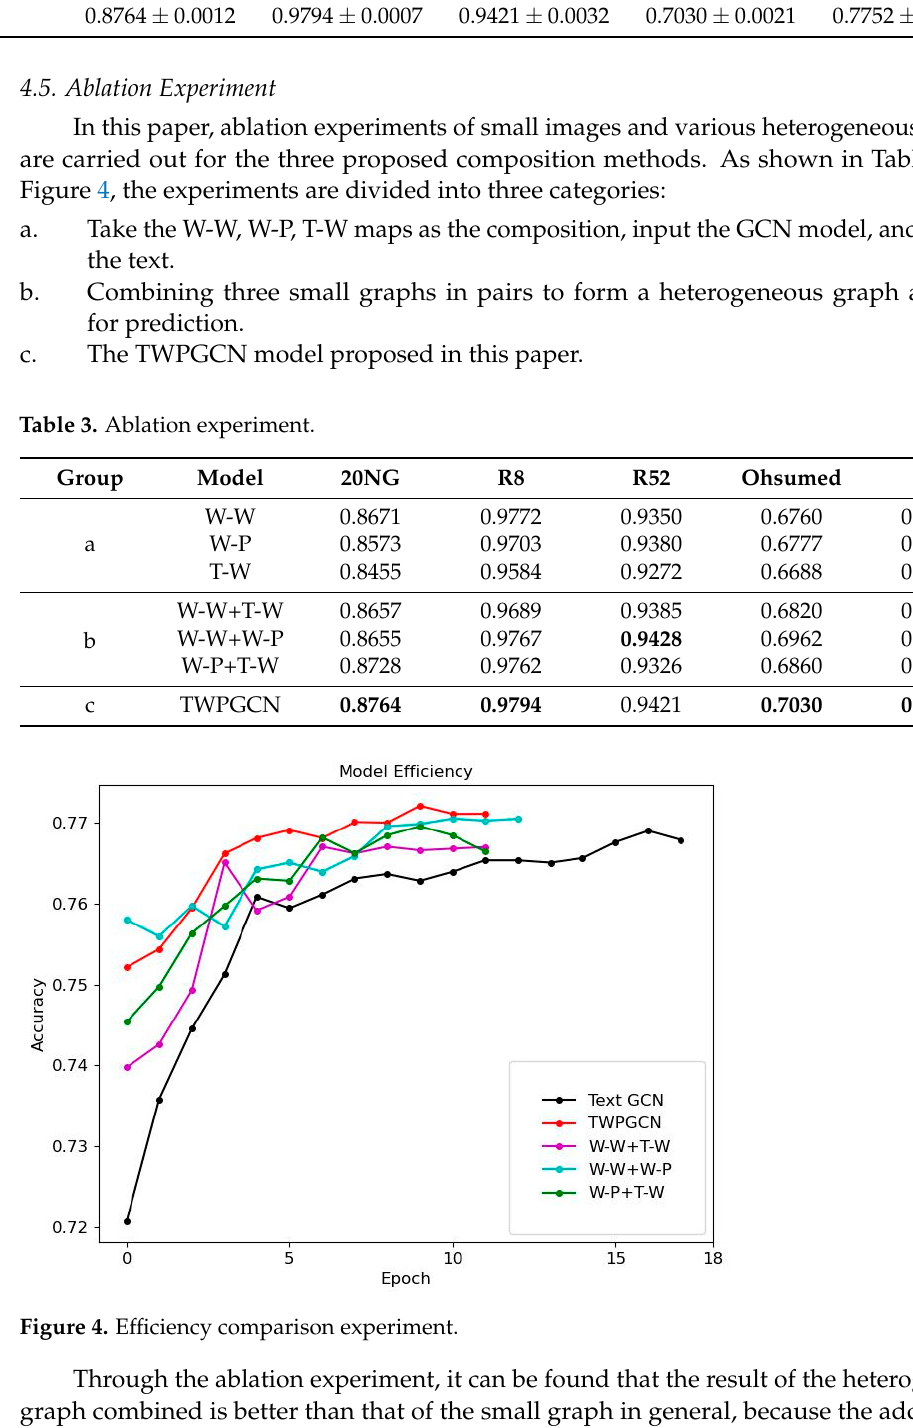
Table 4. Efficiency comparison experiment.